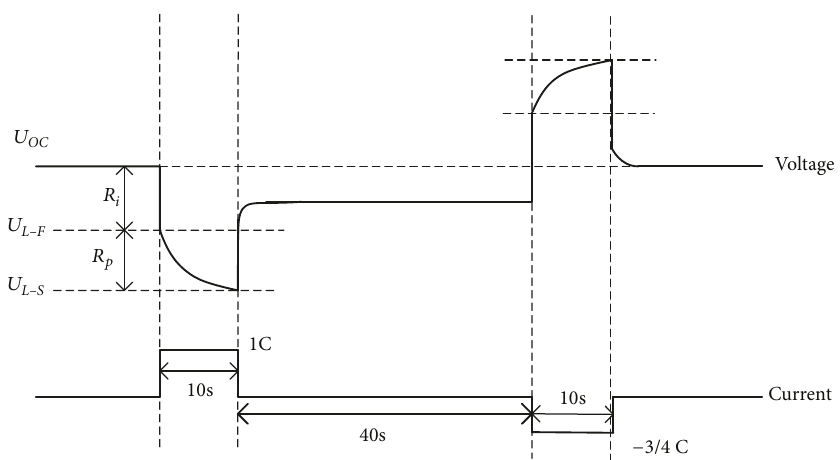
Figure 4: The lithium battery voltage and current changes in the HPPC test.